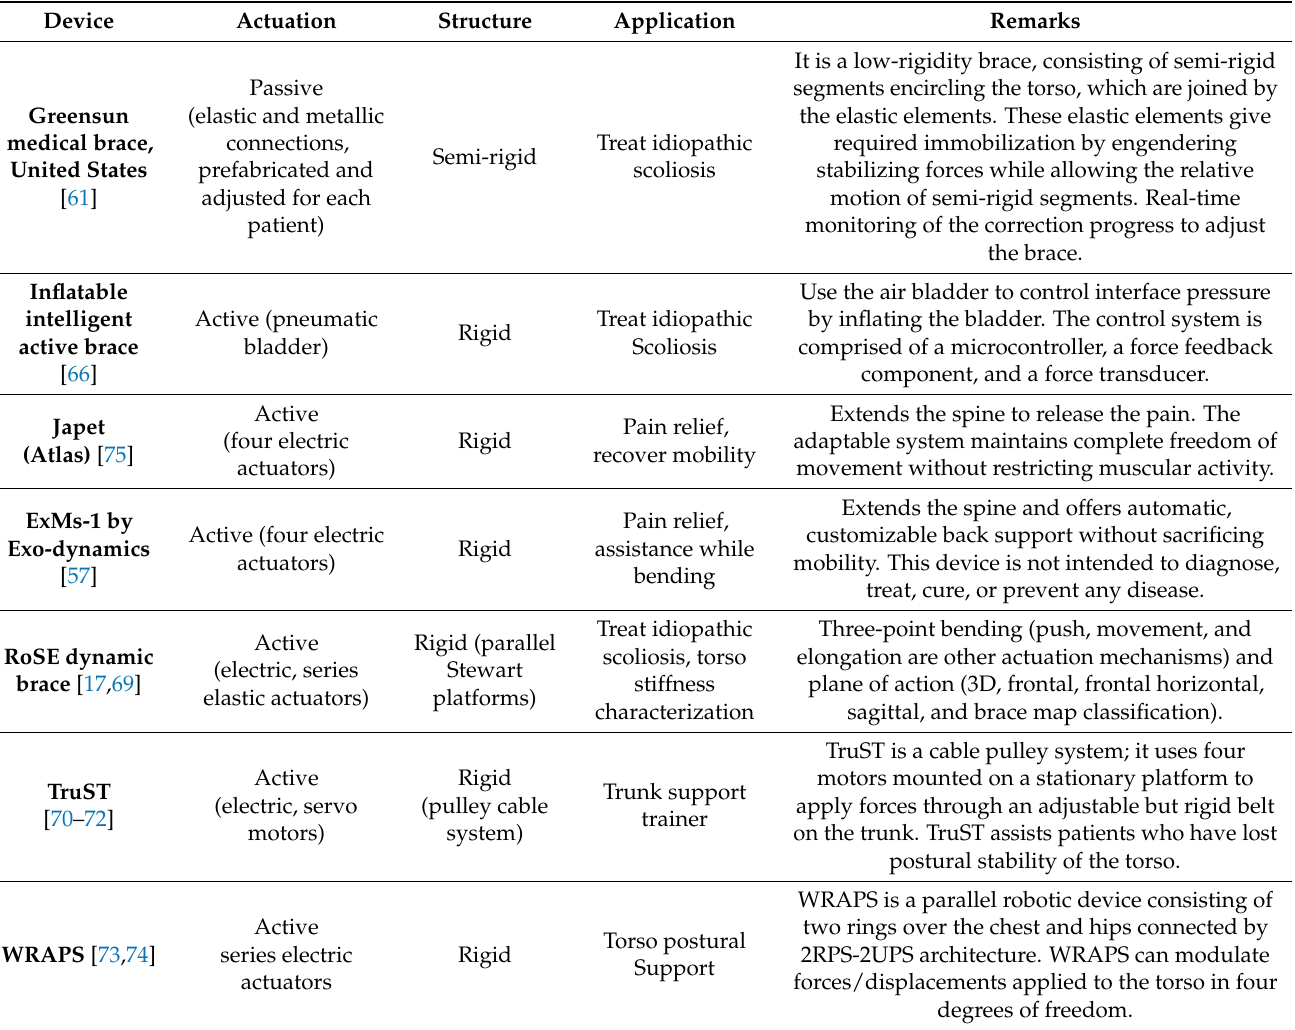
Table 2. Smart rehabilitation orthoses for the spinal